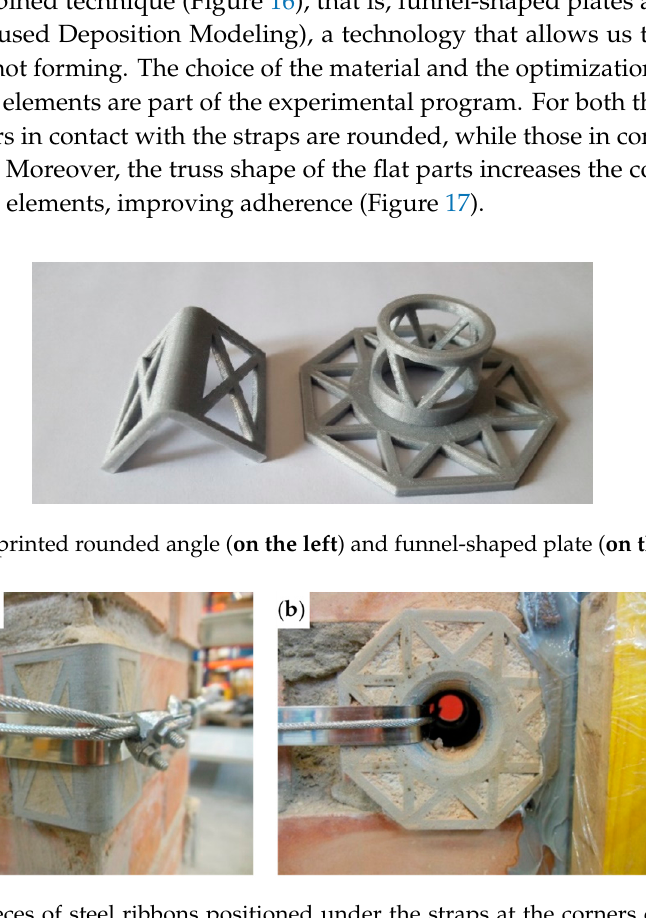
Figure 18. The cross-section of a spiral strand rope, as defined in EN 1993-1-11.